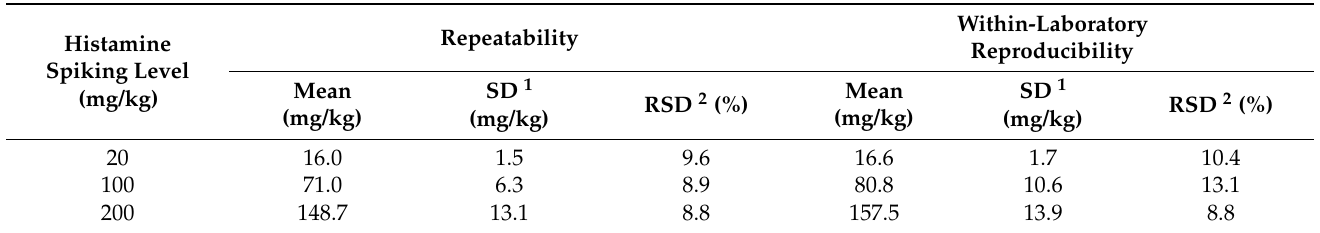
Table 3. Results of repeatability and reproducibility tests calculated for analysis of histamine in tuna samples.